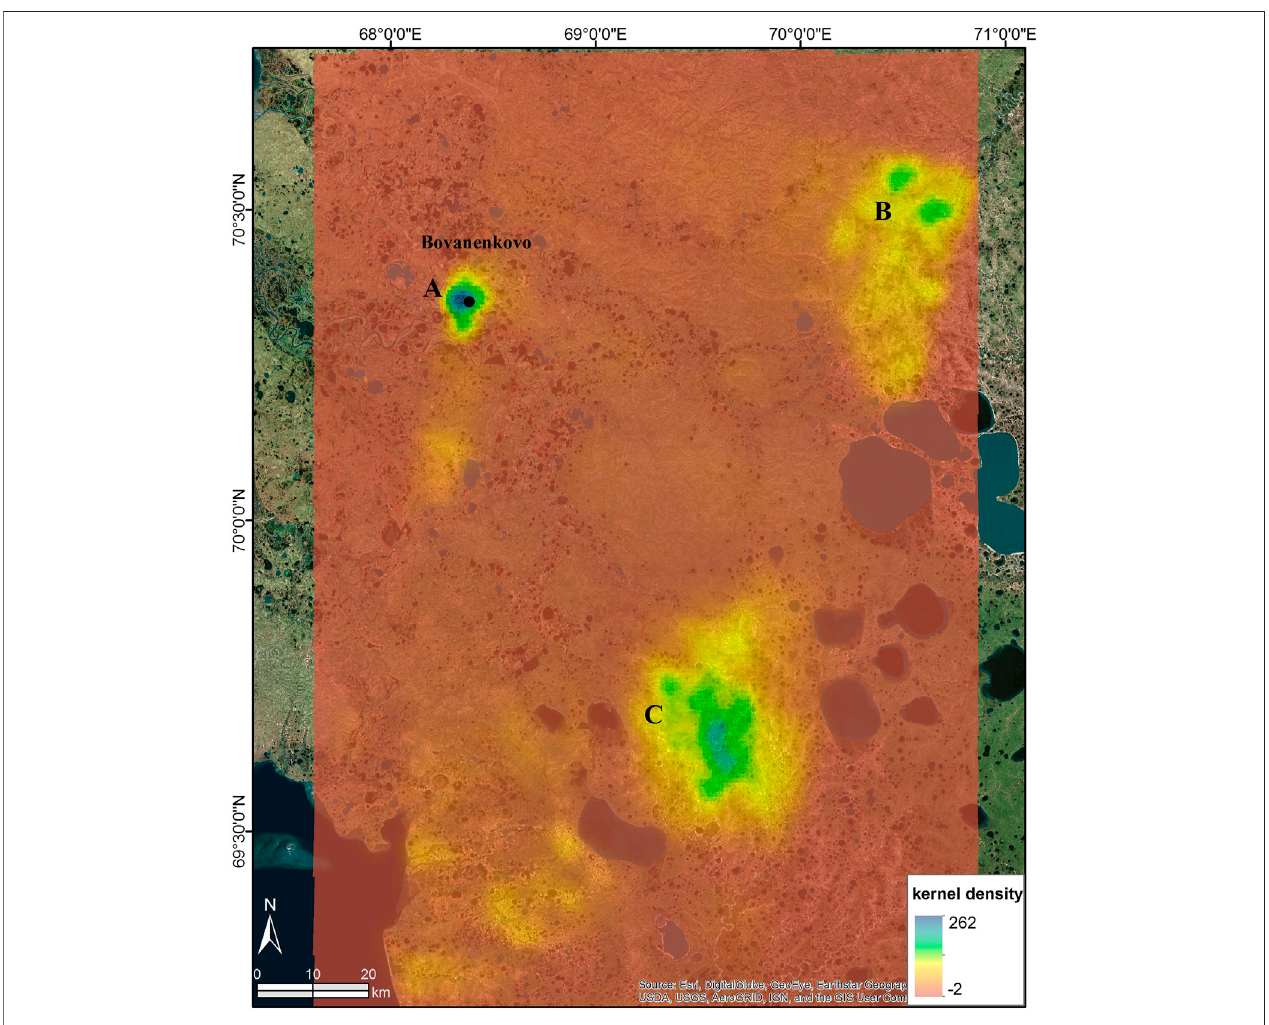
FIGURE4 | Hotspotclusterkernel-density map showing smoothed spatial location ofhotspot clusters inzones (A,B) and (C) . Analysishighlights areas of spatially correlative regions as high kernel-density values in blue. Hotspot analysis was performed on InSAR LOS velocities (cf. Figure 3).